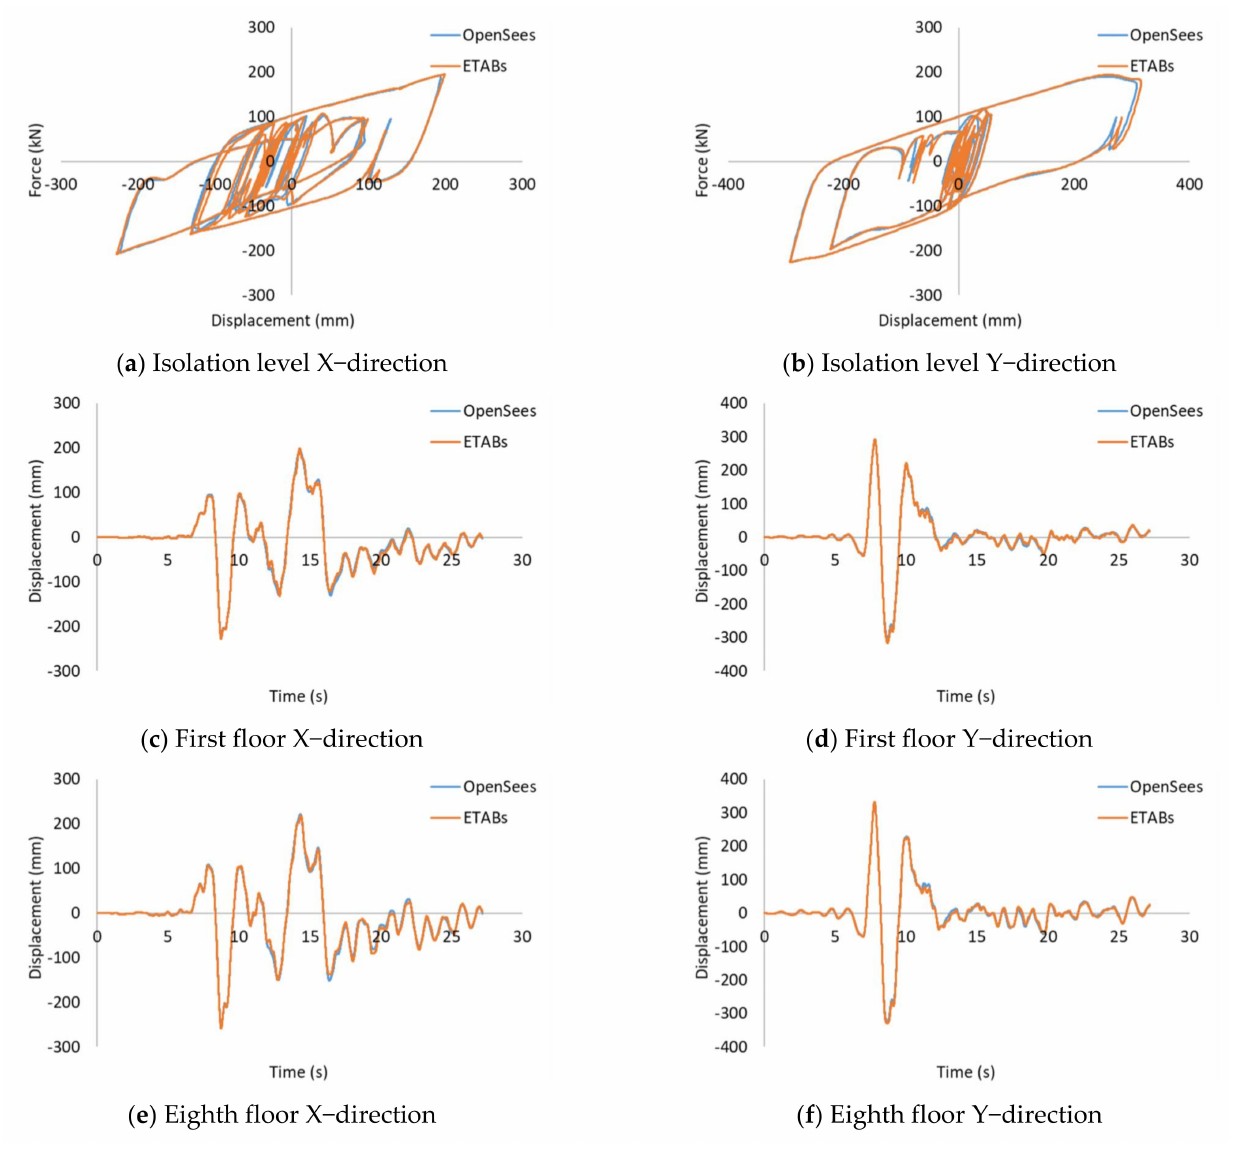
Figure 9. Comparison of OpenSees and ETABs programs